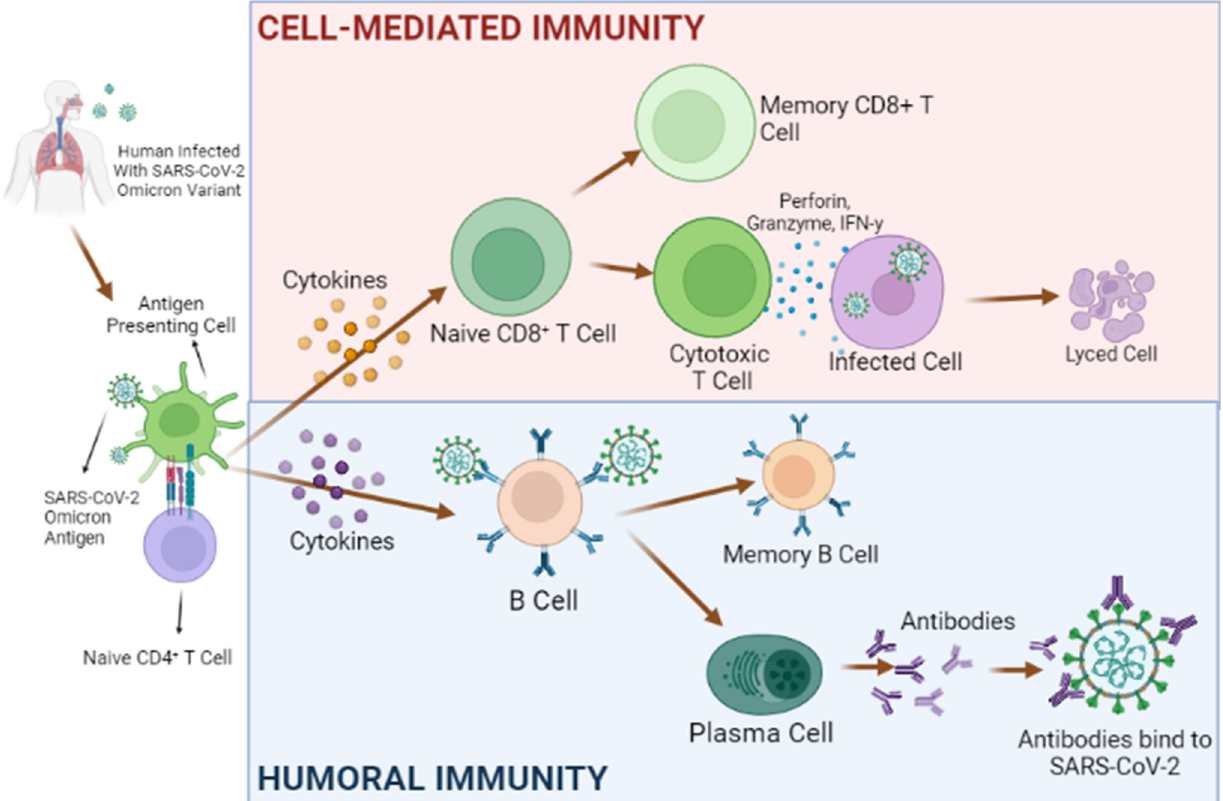
Figure 5. Omicron infection as a natural way of vaccination works by triggering infection-induced immunity, incorporating both humoral and cell-mediated immunity. Adapted from Schijns et al. [102]. The figure is created using Biorender (https://app.biorender.com; accessed on 01 March 2022).